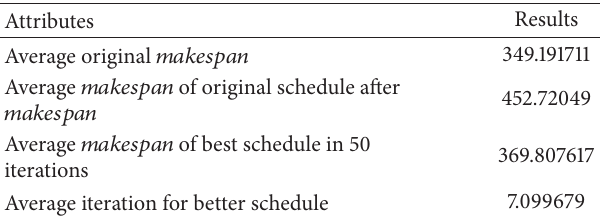
Figure 11: A DAG used for multiple iterations to find the minimum makespan . Table 3: Average results of all experiments.